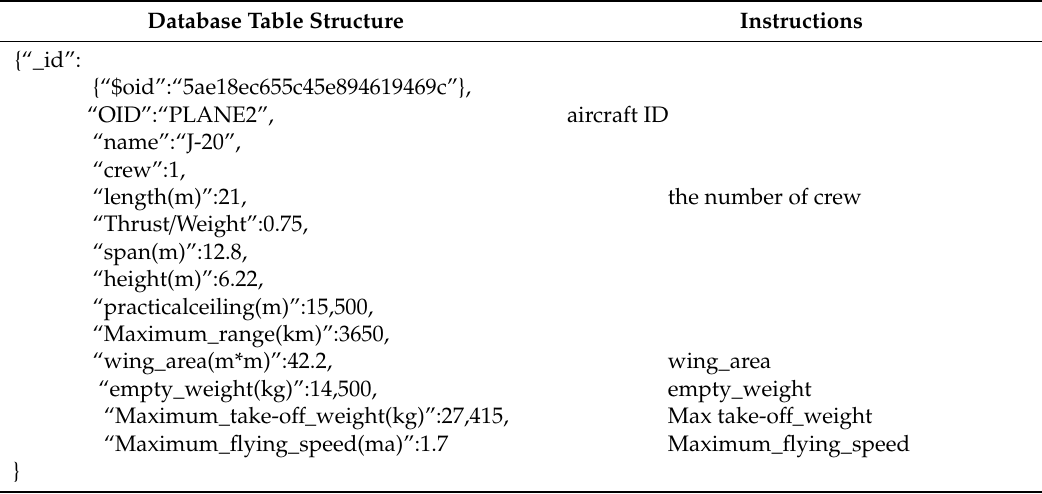
Table 3. Database Table Structure Design 2 of the object